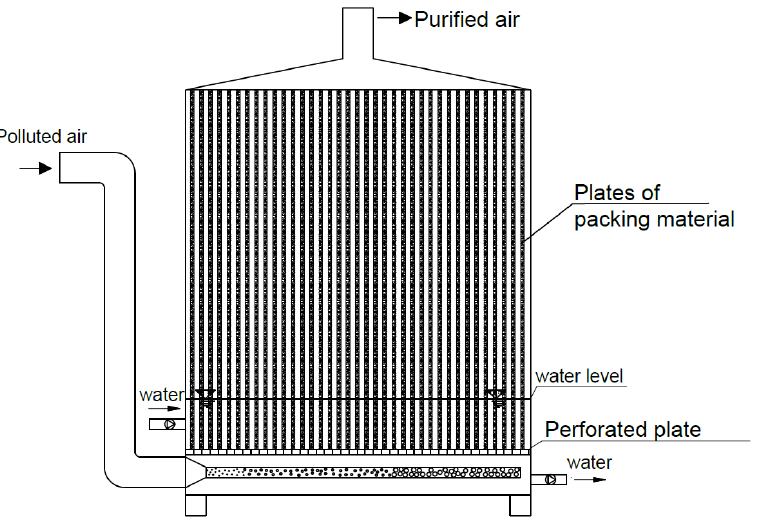
Figure 4. Biofilter with packing material partially immersed to nutrient solution. Reprinted with permission from